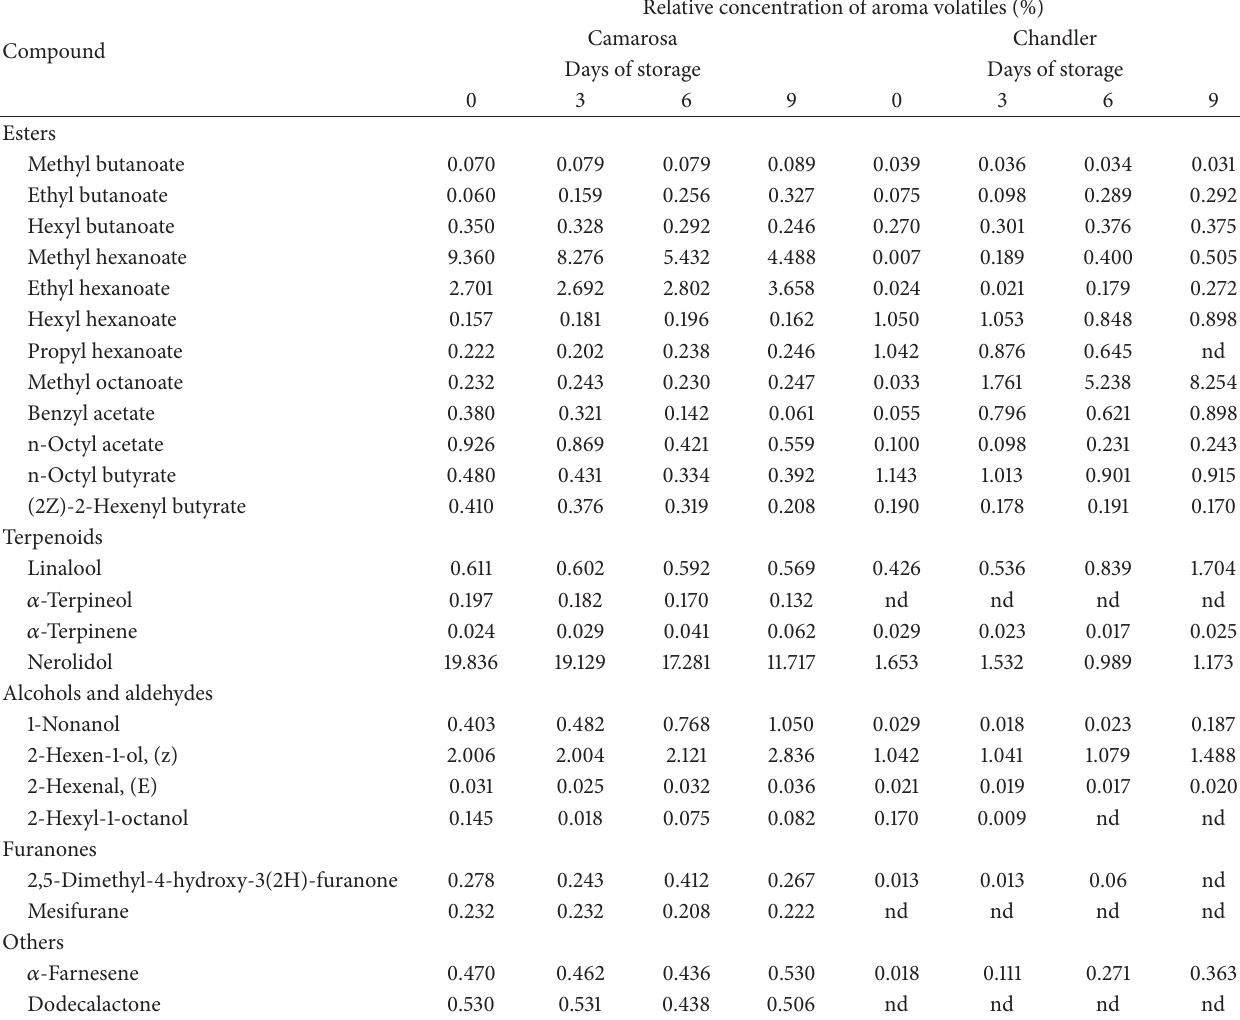
Table 1: Identified aroma compounds by SPME method in both cultivars of strawberry stored at 5 ∘